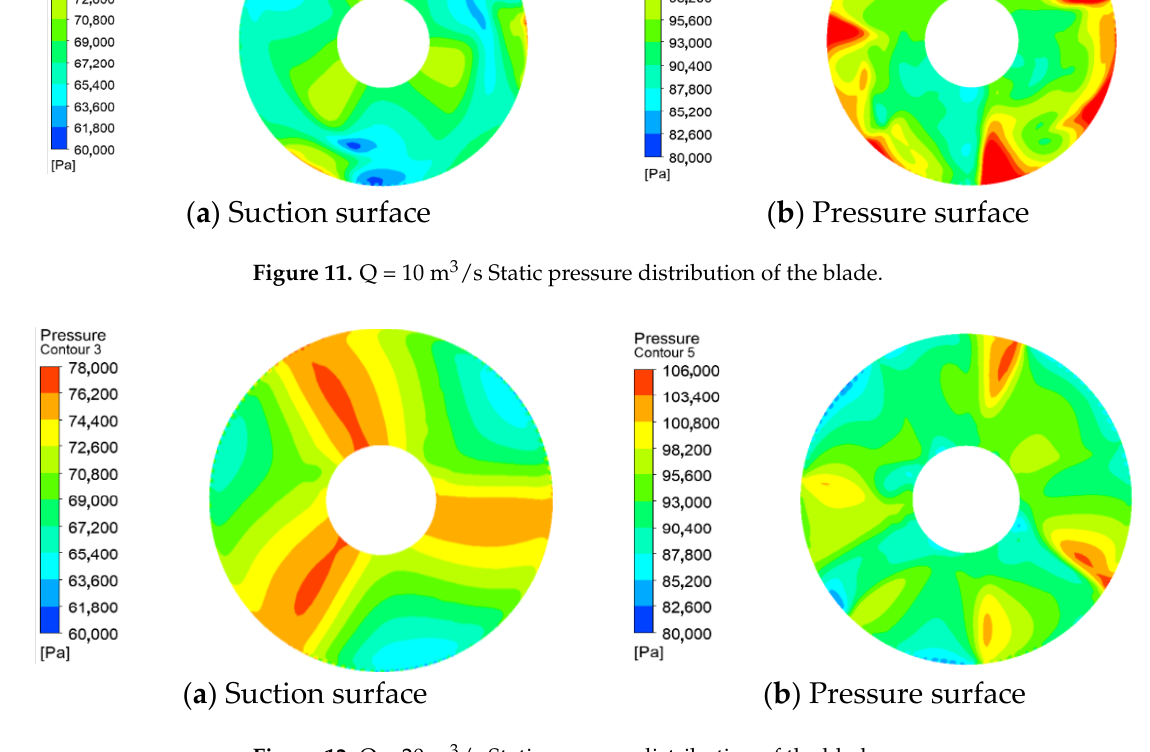
Figure 12. Q = 20 m 3 /s Static pressure distribution of the blade.